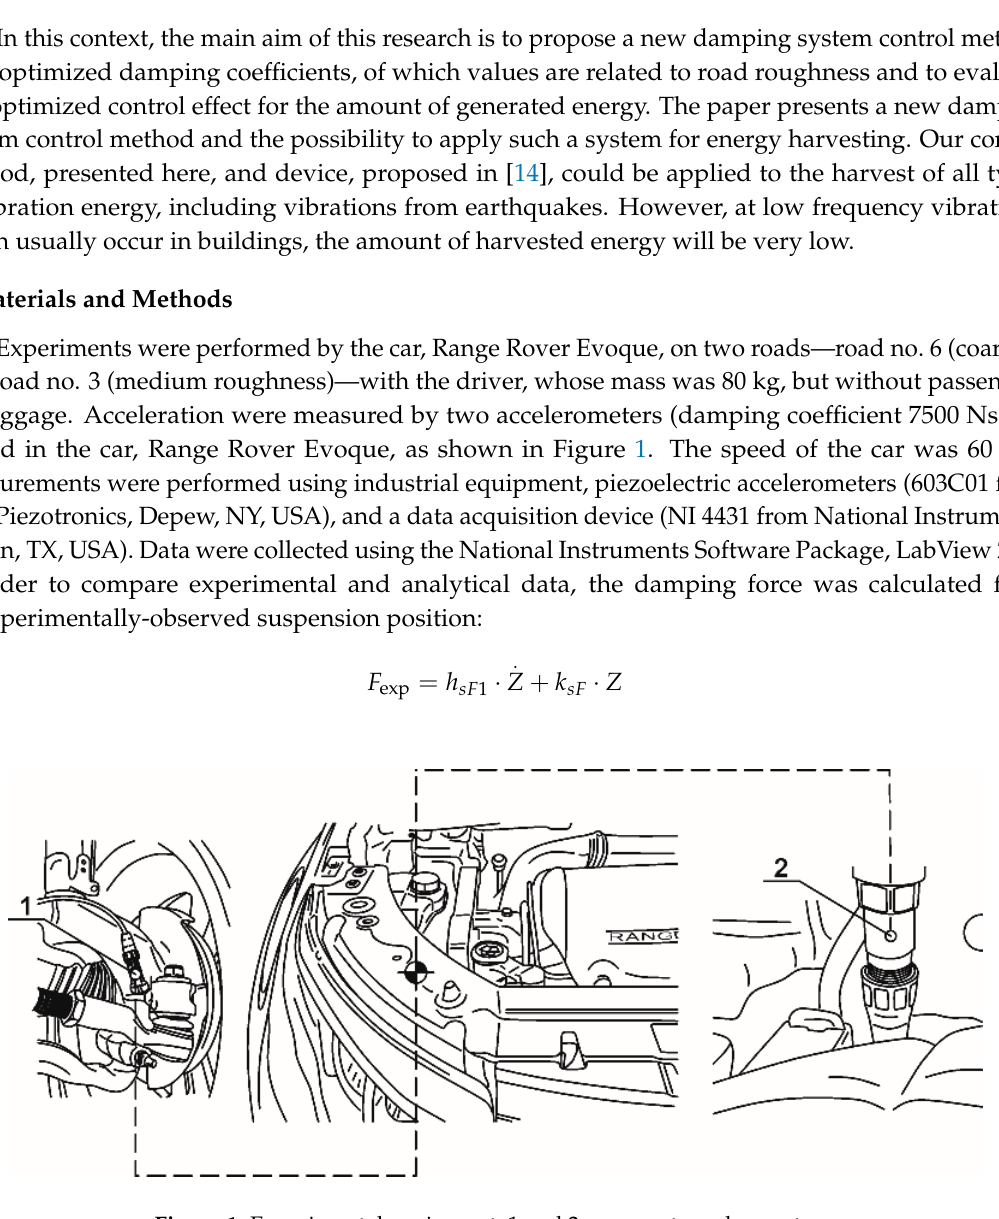
Figure 1. Experimental equipment; 1 and 2 represent accelerometers.